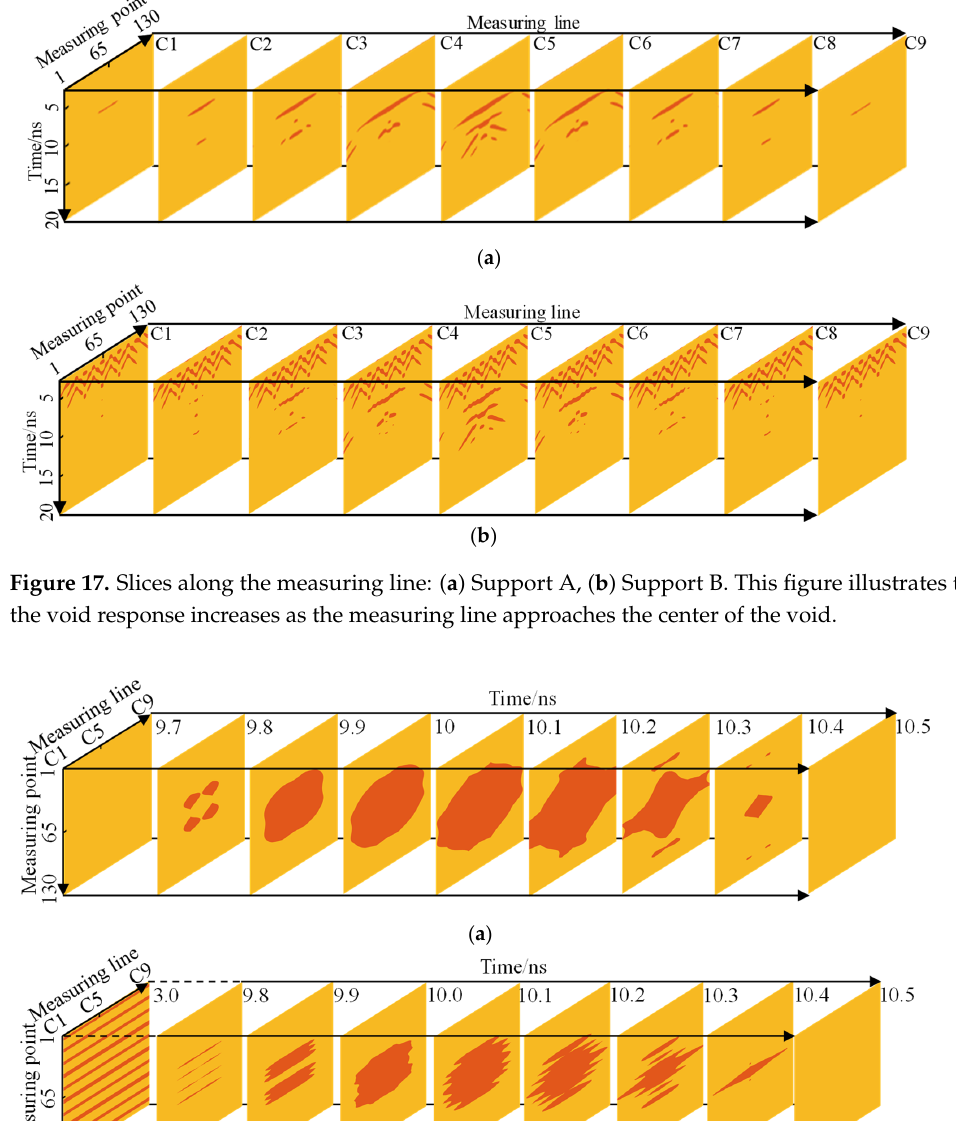
Figure 17. Slices along the measuring line: ( a ) Support A, ( b ) Support B. This figure illustrates that the void response increases as the measuring line approaches the center of the void.